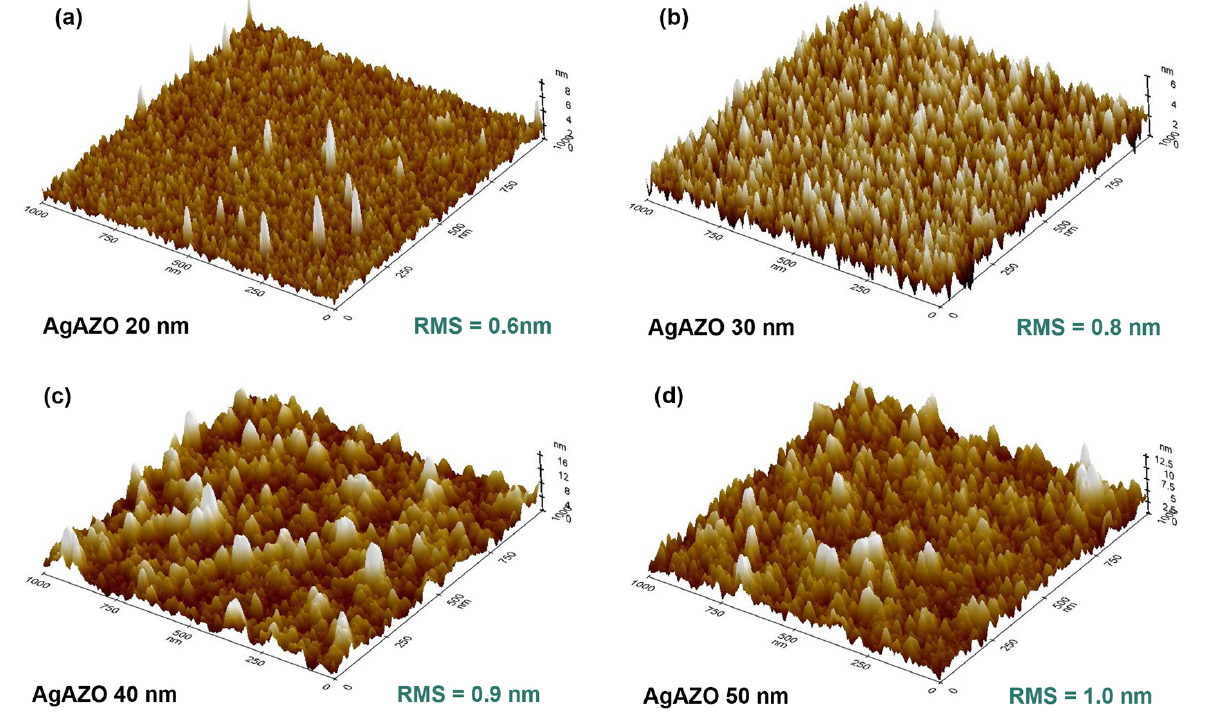
Figure 3. AFM images of the Ag:AZO thin film as a function of thickness. ( a ) 20; ( b ) 30; ( c ) 40; ( d ) 50 nm.